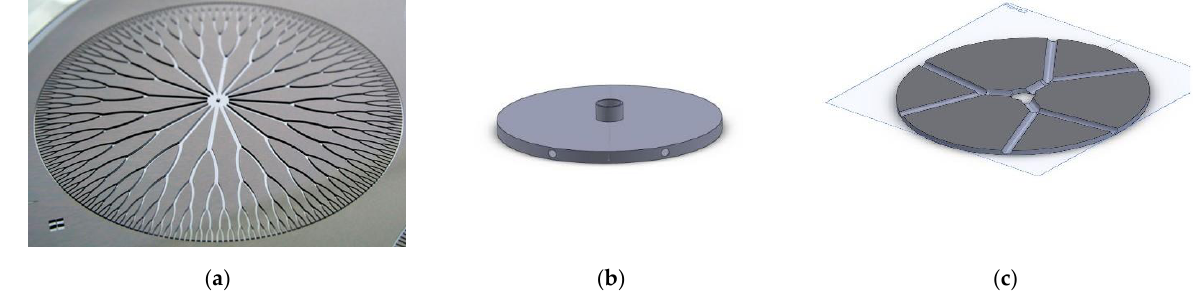
Figure 1. Sketch of a disc-shaped heat exchanger ( a ): highly-branched; ( b ): assembly; ( c ) single- branched configuration.